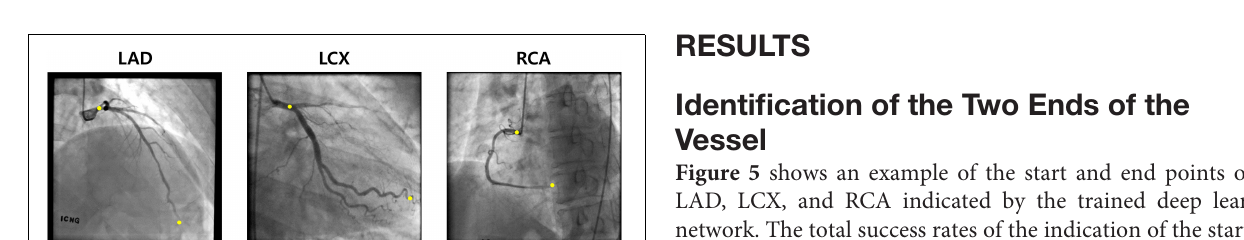
FIGURE 4 | Reconstruction of CA using template model. (A) Template model is viewed from the same angles the angiograms were obtained. For each centerline point of the template model, the distance from the start point along the centerline is calculated and the ratio to the total length is calculated. The correspondences between the segmented vessel centerlines (yellow) are established using the distance ratios obtained from the template model. (B) Geometrical relationships among the CA in 3-D space, X-ray sources and the vessel images on the detectors.